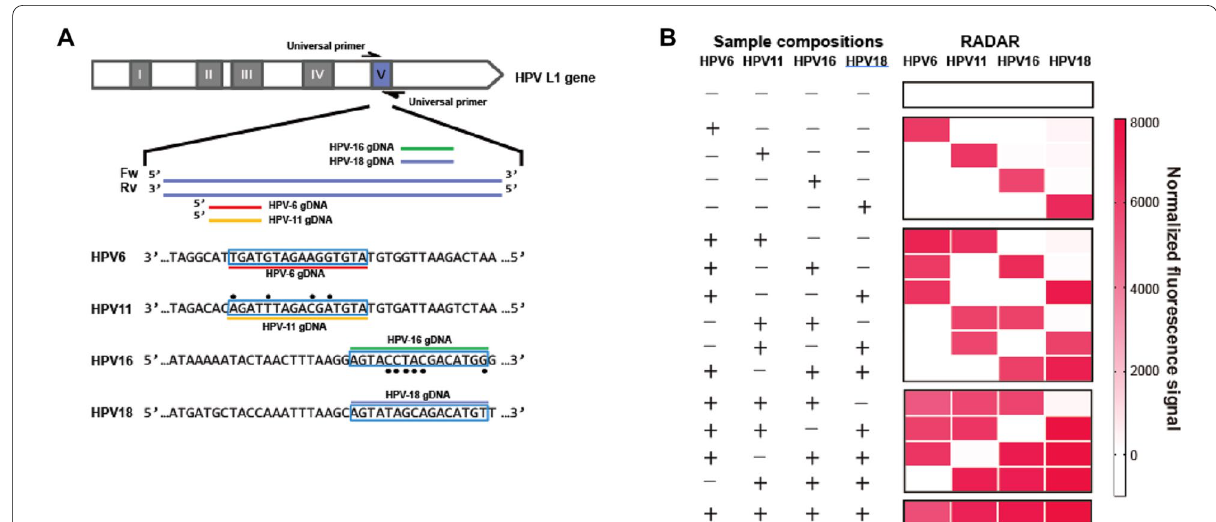
Fig. 5 Multiplex RADAR detection applied for HPV genotyping. A Sequences of the four HPV serotypes within the hypervariable loop V of the L1 gene targeted by gDNAs and Pf Ago. The highlighted bases indicate the designed gDNA sequence. B RADAR detection of one-tube multiplex detection of four dsDNA targets of HPV serotypes with the corresponding designed